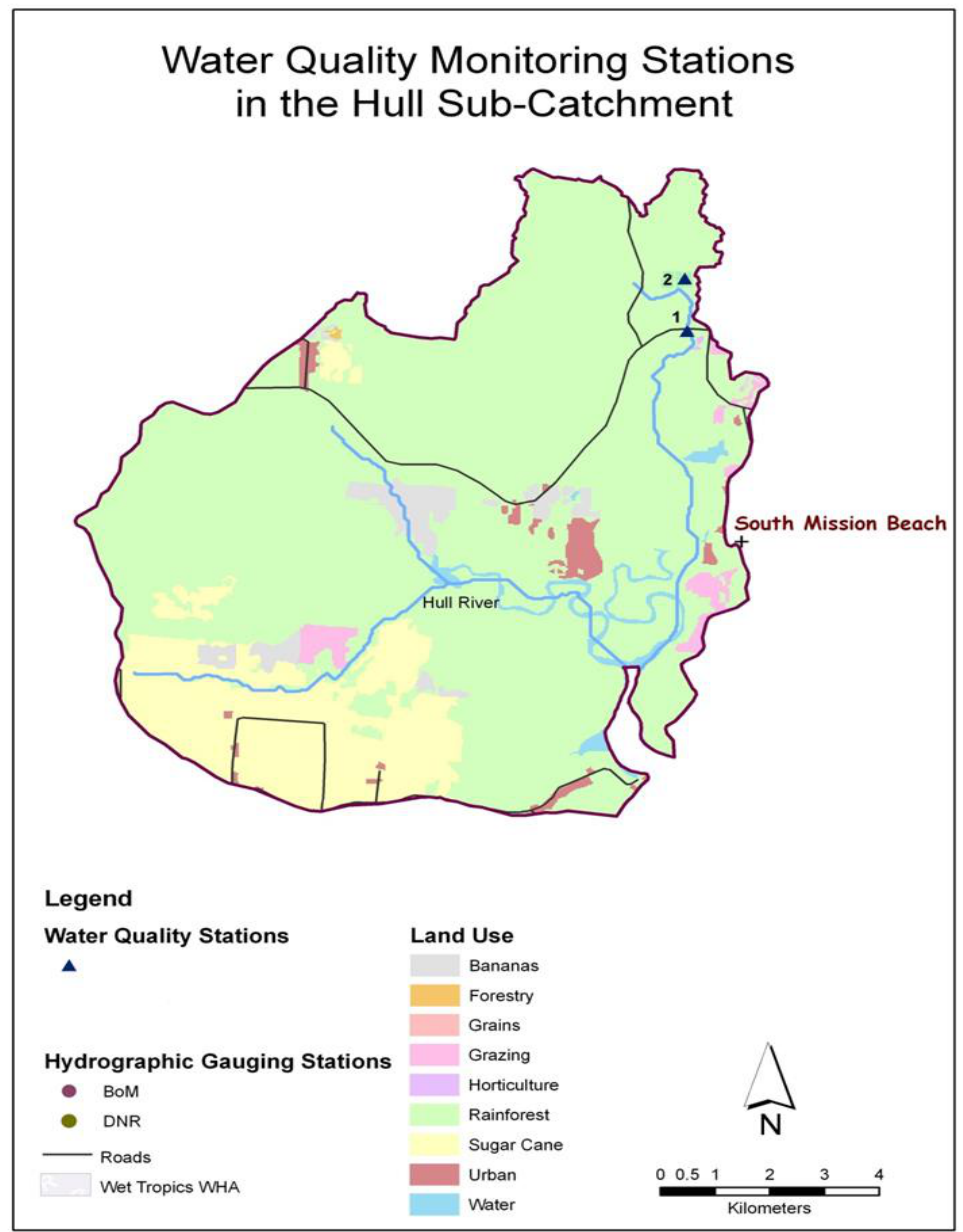
Figure A1. Water quality sampling station locations in the Hull subcatchment.